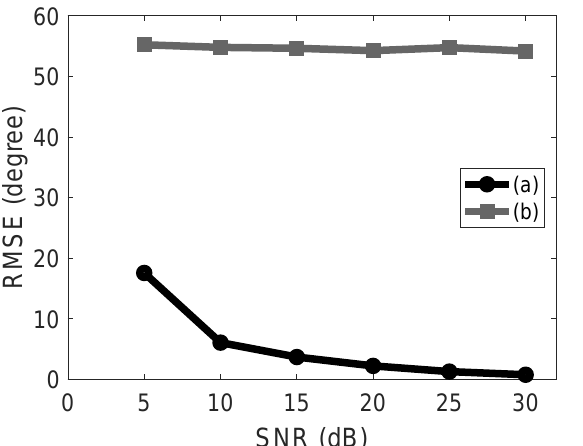
Figure 8. The implemented solution with RF switch compensation (a) and without it (b) run in a simulation